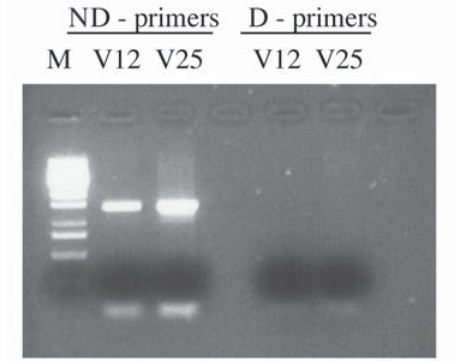
1. Ethidium bromide-stained agarose gel showing result of PCR experiments with the specific ND- and D- primer pairs. M, molecular-weight marker 1 kb lad- der (Eurogentec, Angers, France). Note the selective amplification of a 1.5-kb fragment with ND-primers, only.